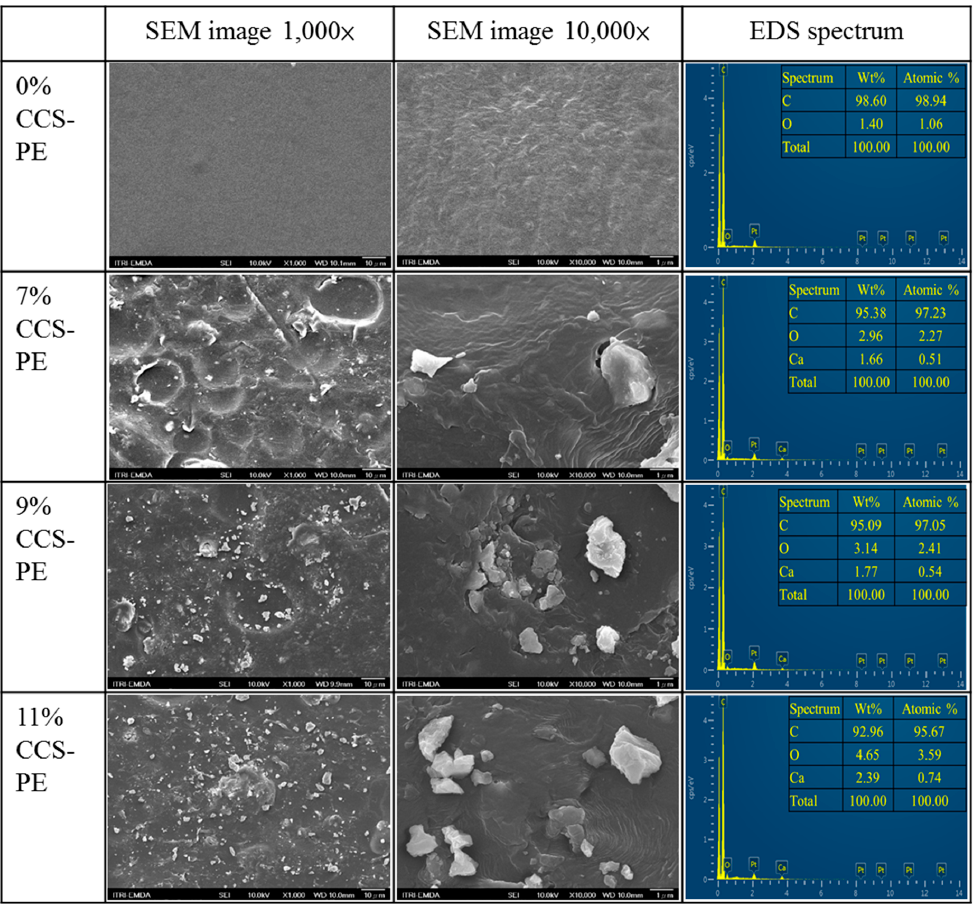
Figure 2. Scanning electron microscope (SEM) image of 0%, 7%, 9%, and 11% CCS-PE plastic bags at 1000×, 10,000× magnification, and the corresponding energy-dispersive spectroscopy (EDS) spectrum.